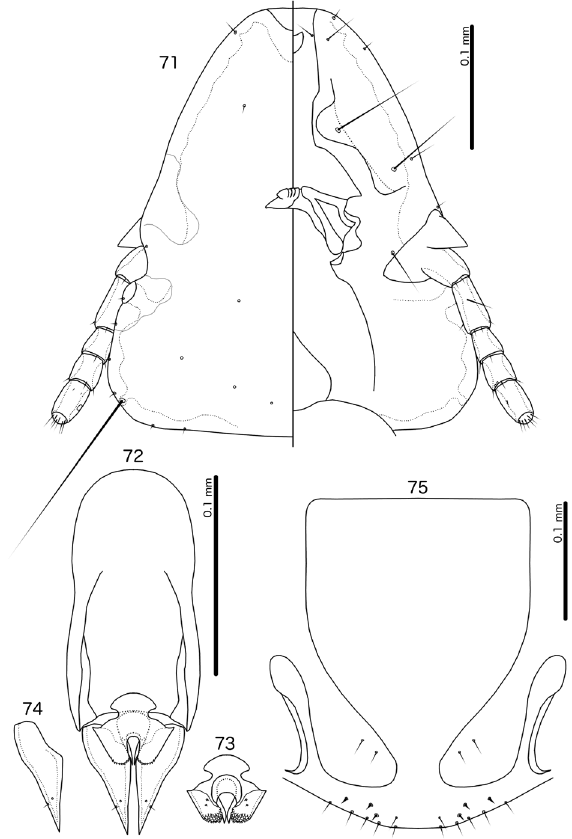
Figures 71–75. Brueelia matvejevi Balát, 1981, ex Turdus viscivorus Linnaeus, 1758. 71 Male head, dorsal and ventral views 72 Male genitalia, dorsal view 73 Male mesosome, ven- tro-lateral view 74 Male paramere, dorsal view 75 Female sub- genital plate and vulval margin, ventral